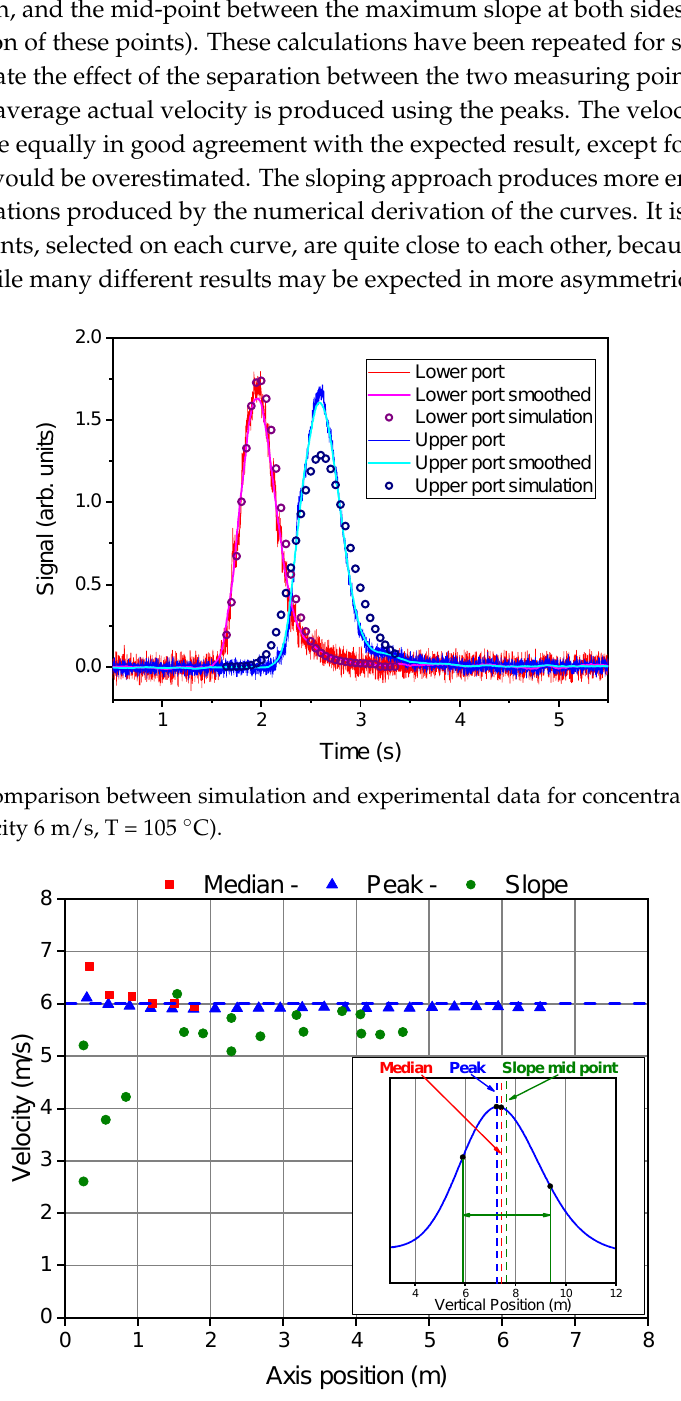
Figure 12. Calculated velocities using different points on the simulated tracer concentration curves at different times (average velocity 6 m/s, T = 105 ◦